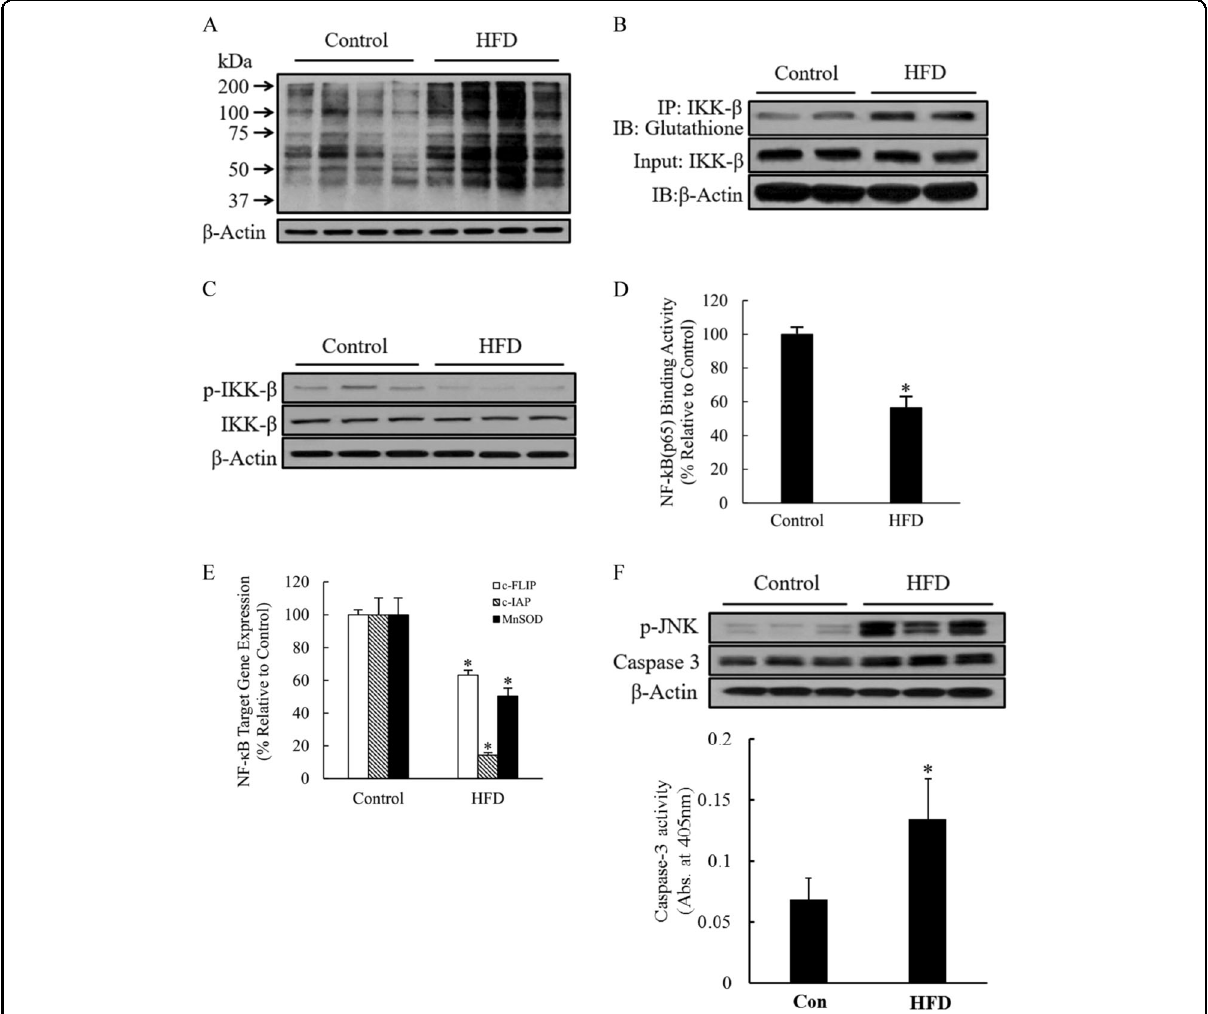
Fig. 7 Long-term HFD consumption increases IKK- β glutathionylation and suppresses NF- κ B activation in the liver. Male C57BL/6 mice were fed with either a control diet or high-fat diet (HFD) for 12 weeks. a Hepatic protein-SSG adduct levels. b Hepatic glutathionylated IKK- β levels. c Hepatic IKK- β phosphorylation. d Hepatic nuclear p65/DNA-binding activity. e NF- κ B-targeted gene expression in the liver. Data are expressed as the mean ± SD ( n = 6). * p < 0.05 versus control. f Hepatic JNK and caspase-3